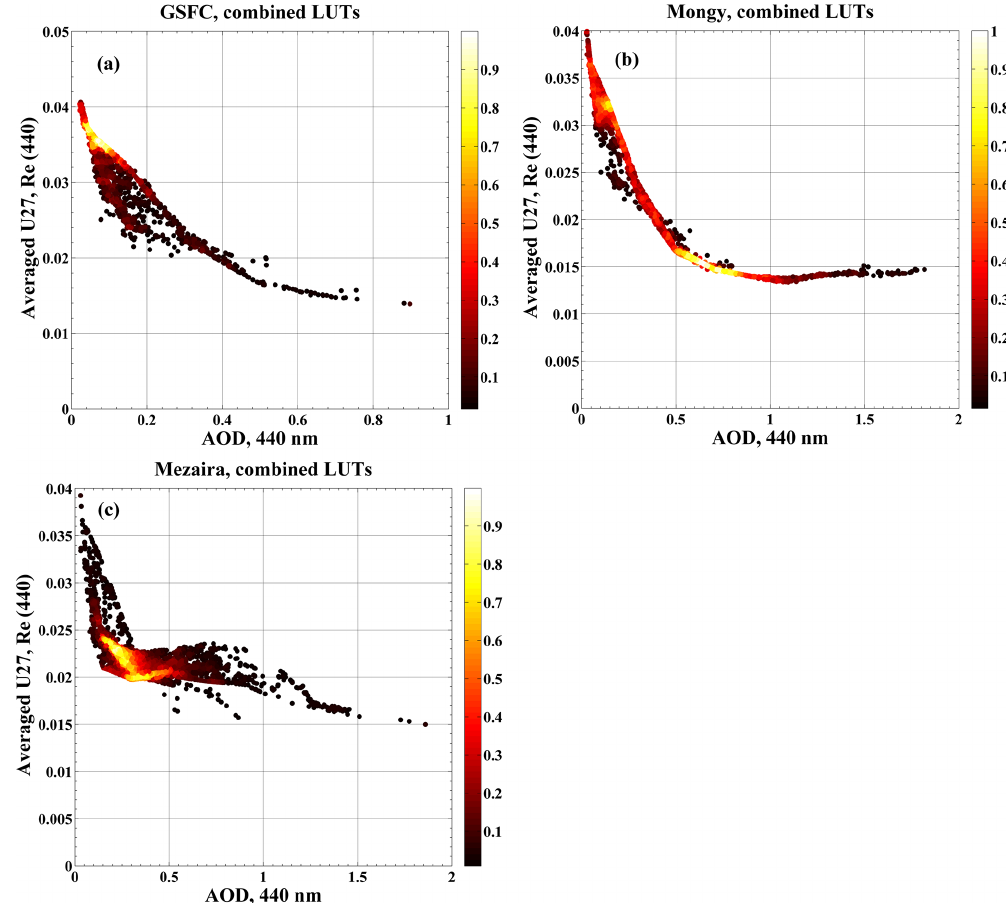
Figure 24. Uncertainties of the real part of refractive index estimated at 440nm: (a) GSFC, (b) Mongu, (c)